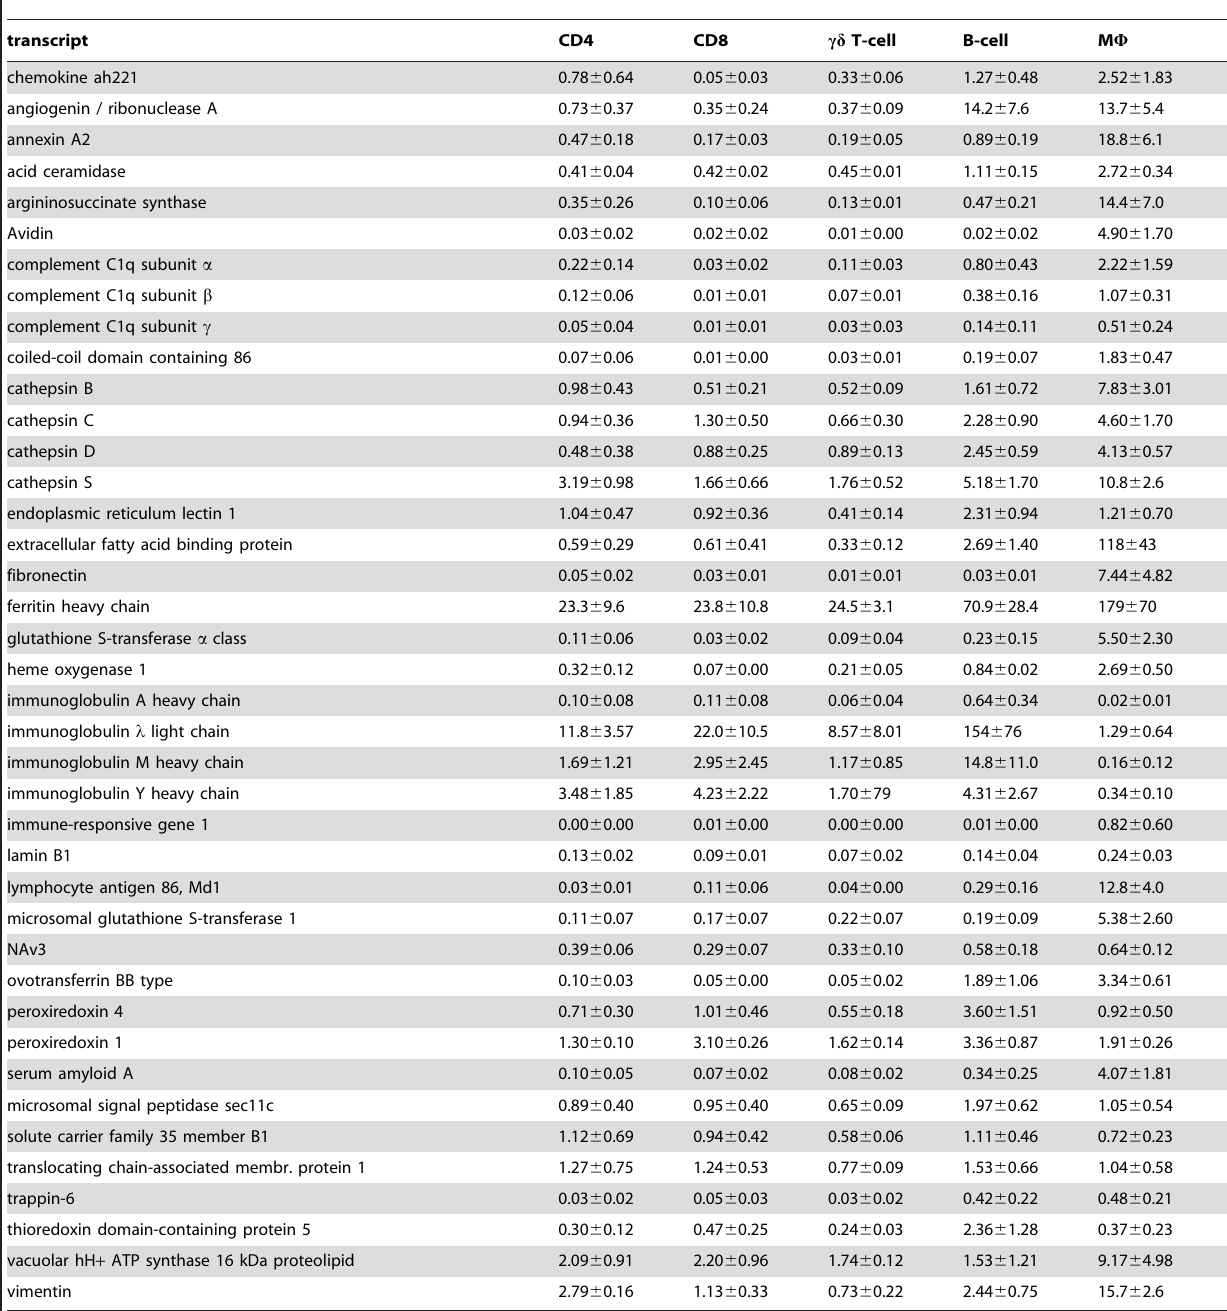
Table 2. Basal expression of individual genes in sorted leukocyte subpopulations in the absence of infection.